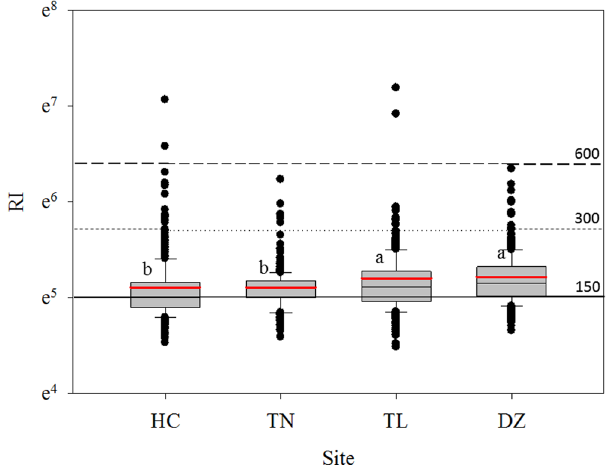
Figure 3. Boxplot of RI in the four counties of the upper Yangtze Basin, China (different letters show significant differences at p < 0.05 by ANOVA) (symbols for boxplot are similar to Fig.